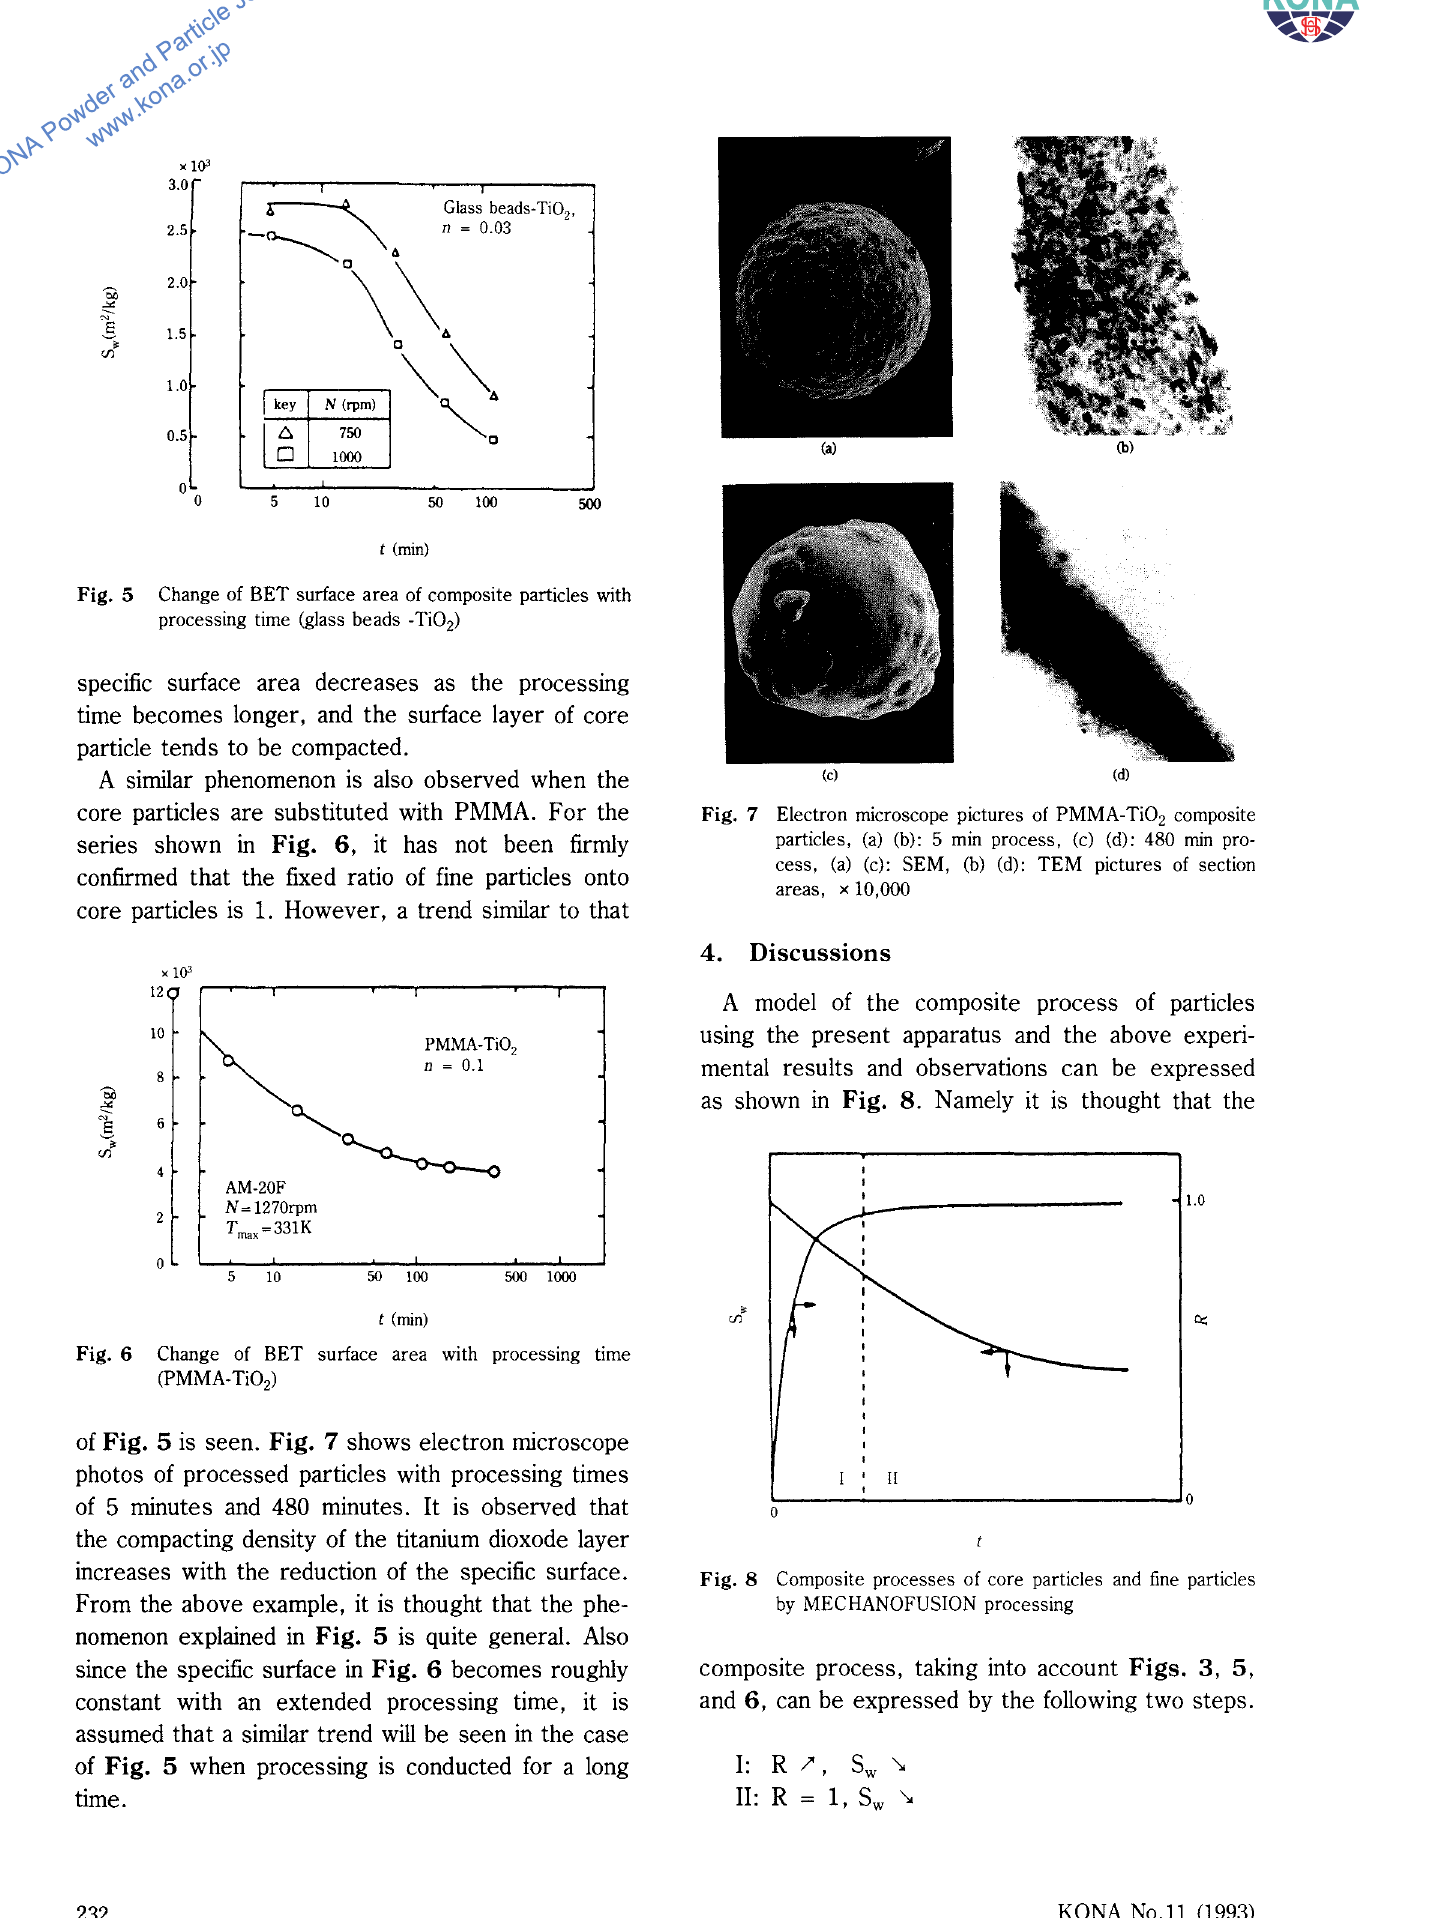
Fig. 8 Composite processes of core particles and fine particles by MECHANOFUSION processing composite process, taking into account Figs. 3, 5, and 6, can be expressed by the following two